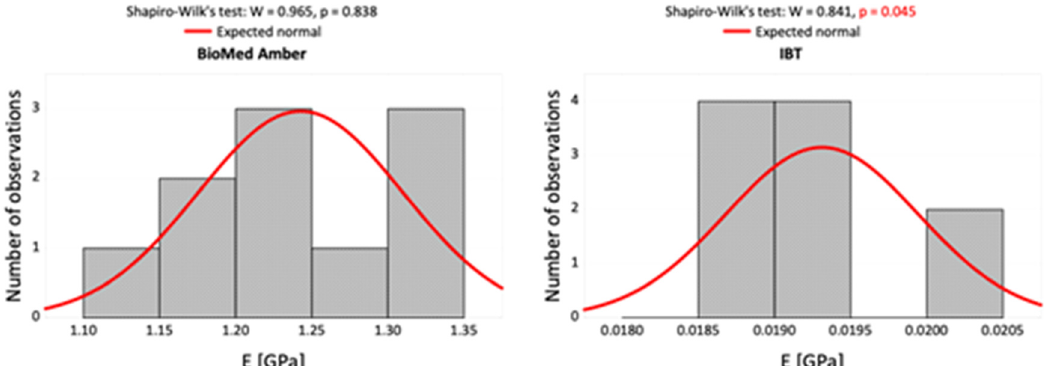
Figure 5. Histograms of the measurement results of Young’s modulus in the tensile test against a background of normal data distribution for the two dental resins and the normality test results.